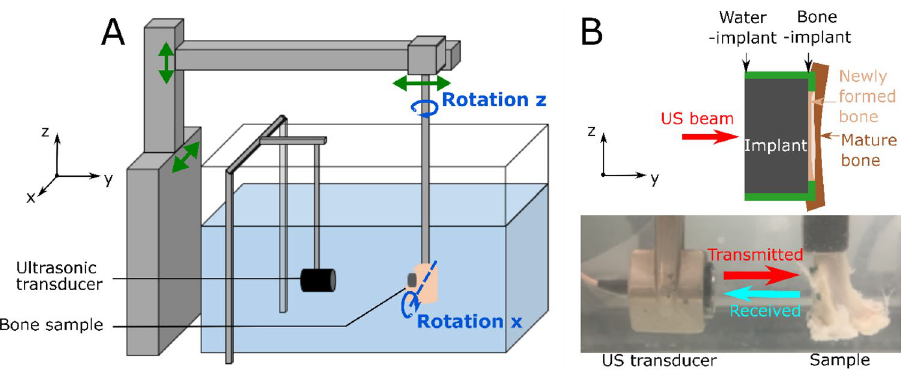
Figure 2. ( A ) Schematic representation of the quantitative ultrasonic device. The green arrows indicate the translation of each component. ( B ) Photo of the measurement set-up including the ultrasonic transducer acting as an emitter-receiver and the sample. The top schematic view of the implant indicates the positions of the water-implant and the bone-implant